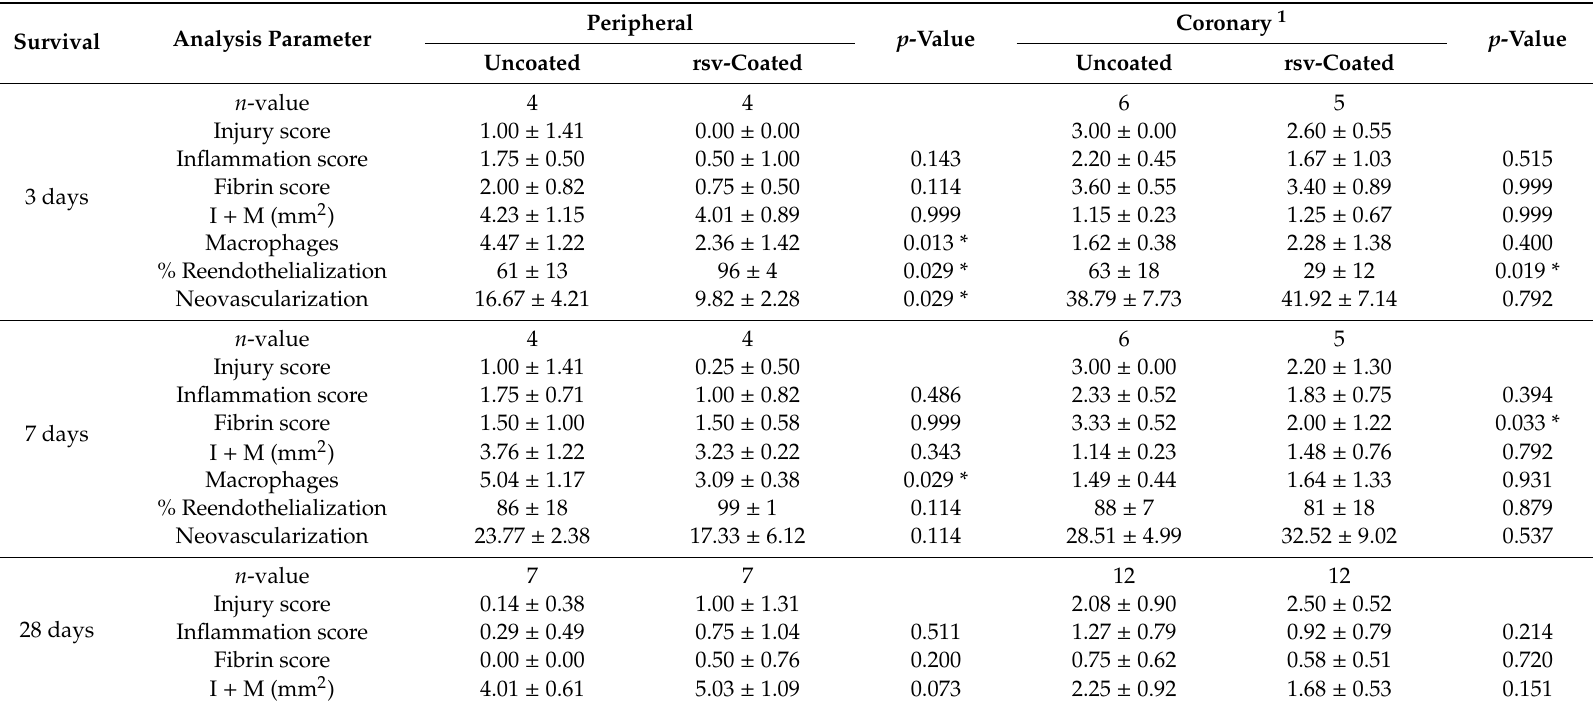
Table 1. Summary of results. n -value: Number of arteries included; I + M: Intima–media area; Macrophages: Relative fluorescence of immunofluorescent-stained Mac-2; values are mean ± SD; p -value determined by Mann–Whitney test; * p ≤